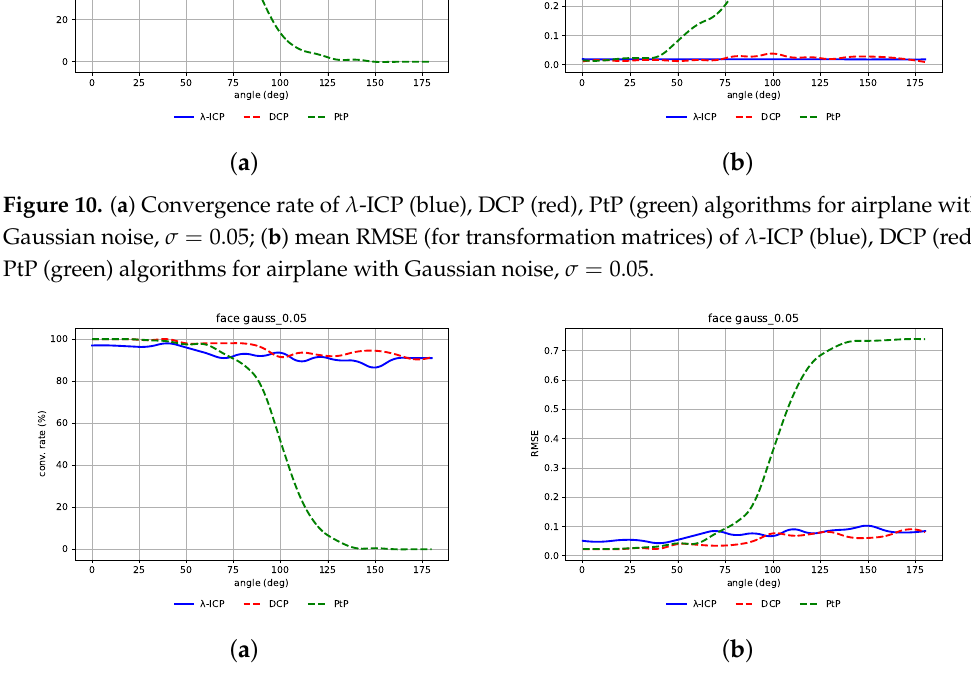
Figure 11. ( a ) Convergence rate of λ -ICP (blue), DCP (red), PtP (green) algorithms for human face with Gaussian noise, σ = 0.05; ( b ) mean RMSE (for transformation matrices) of λ -ICP (blue), DCP (red), PtP (green) algorithms for human face with Gaussian noise, σ = 0.05.